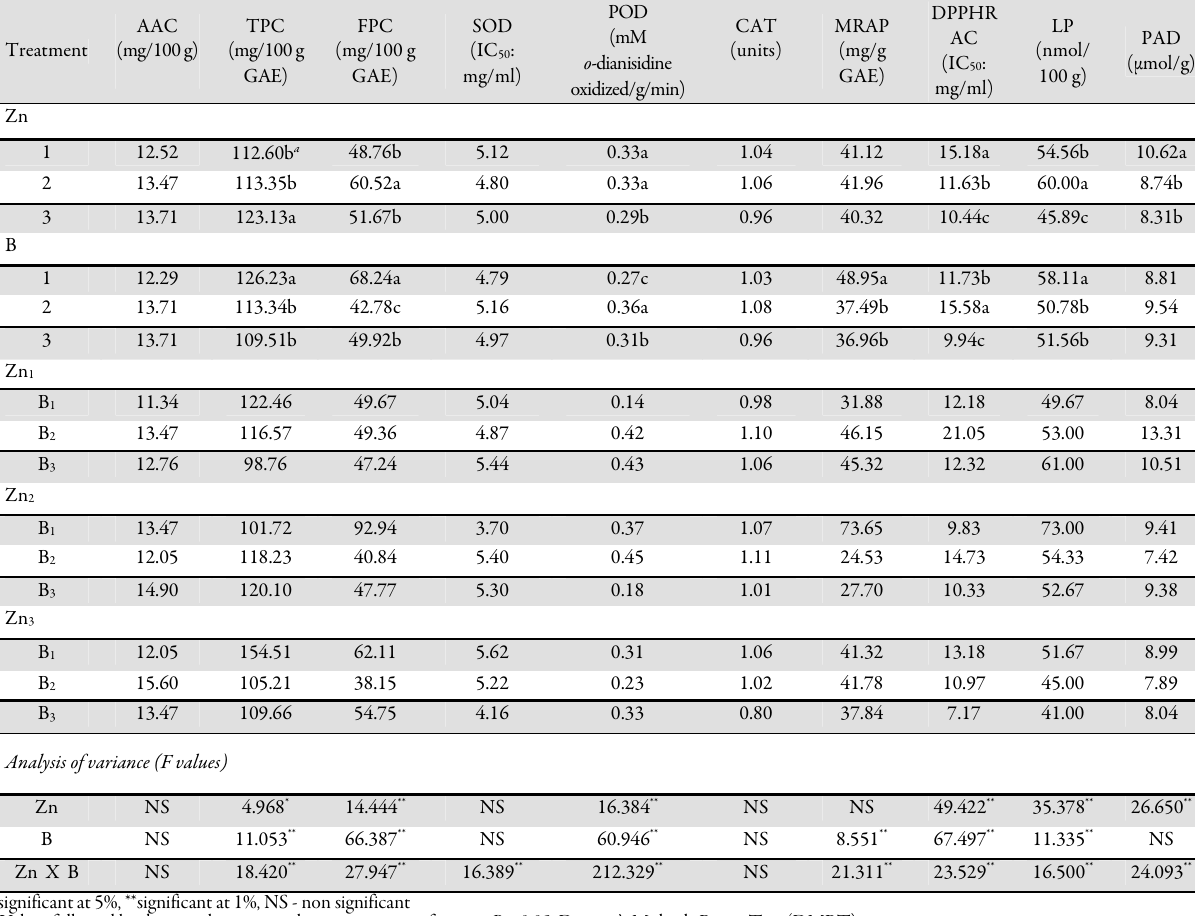
Table 2. Effect of Zn and B on antioxidants content and antioxidant activity along with pyruvic acid development in onion Treatment